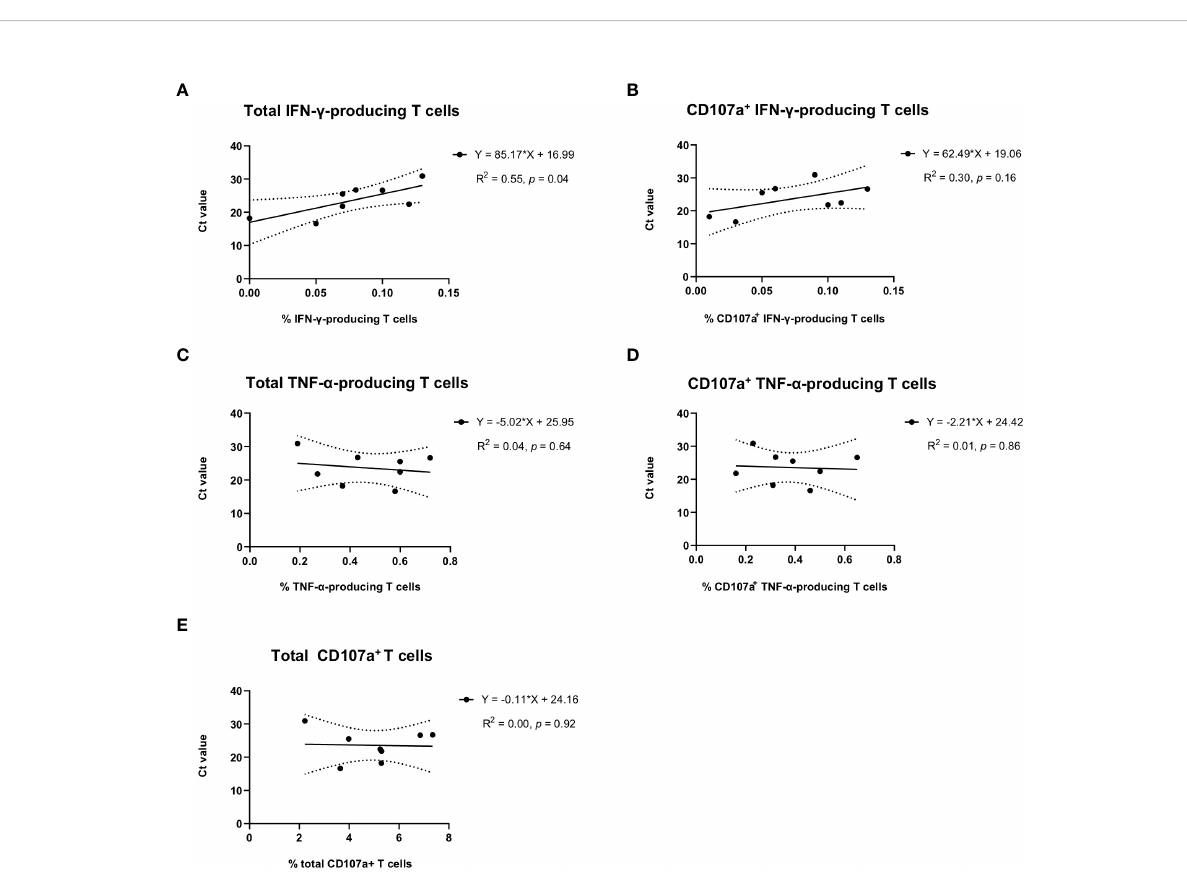
FIGURE 5 Correlation of virus-speci fi c IFN- g , TNF- a , or CD107a T cells in sows with the average Ct values of umbilical cords of newborn piglets per litter. Average Ct values of umbilical cords from the same litter of newborn piglets were used to indicate the infection status of newborn piglets. Solid lines, linear regression of the correlation between Ct values of newborn piglets and PRRSV-1 JA2-speci fi c (A) total IFN- g -producing or (B) CD107a + IFN- g -producing T cells, (C) total TNF- a -producing or (D) CD107a + TNF- a -producing T cells, and (E) total degranulated (CD107a + ) T cells detected in each sow. Each solid circle represents one sow that delivered infected piglets. The value was the mean percentage of two replicas with background (cultures in the absence of PRRSV-1 JA2 stimulation) subtracted. Dashed lines, 95% con fi dence intervals; R 2 , fi t goodness; p values, slope signi fi